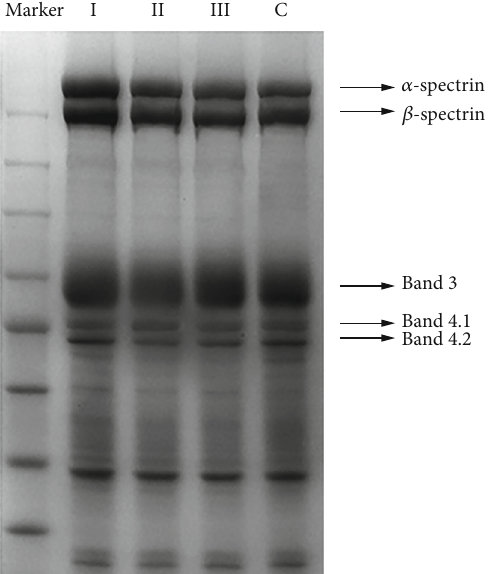
Figure 4: SDS-PAGE analysis of erythrocyte membrane proteins using Coomassie brilliant blue staining. Lines I, II, III, and C correspond to erythrocyte membrane proteins from I-1, II-1, III-1, and a healthy control individual,